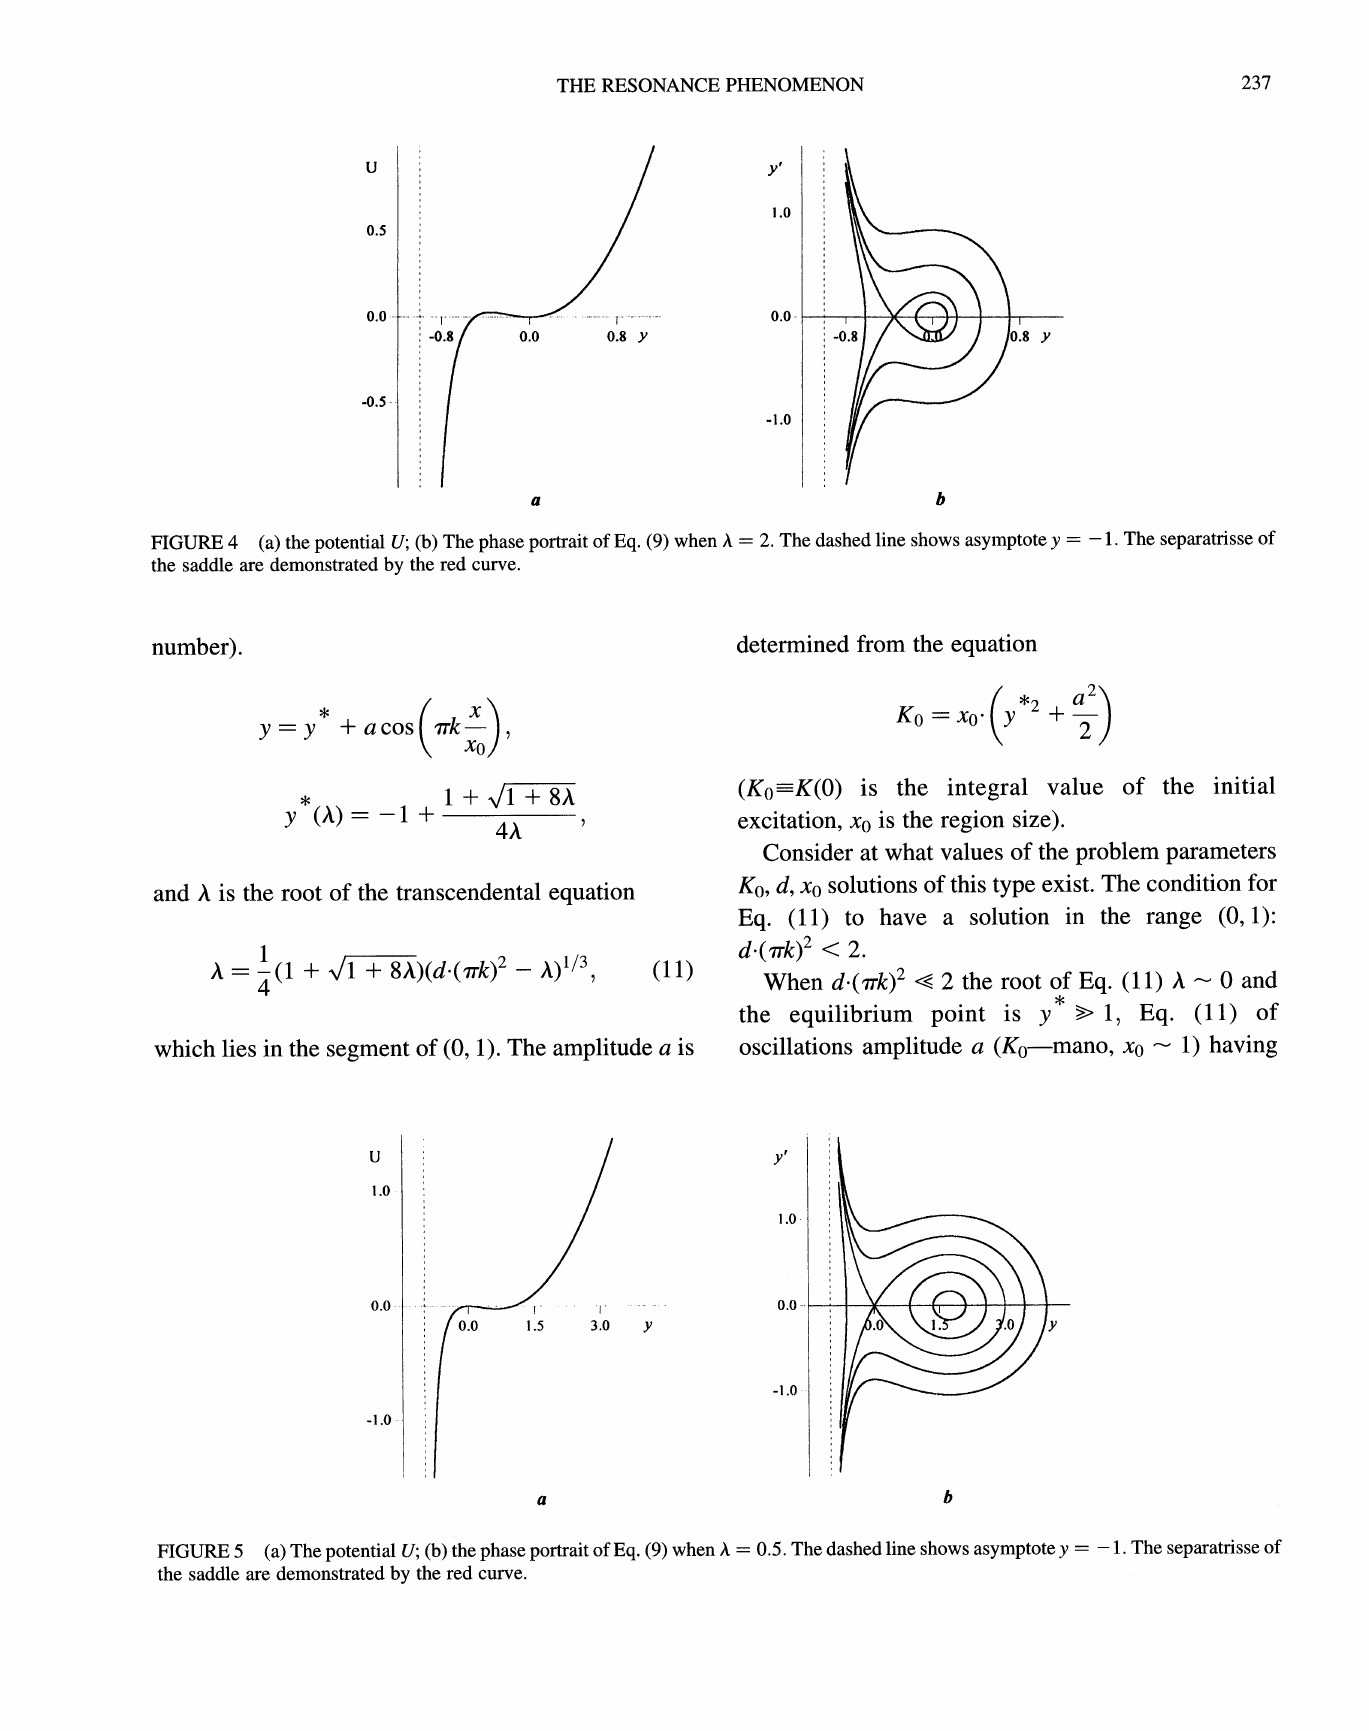
FIGURE 5 (a) The potential U; (b) the phase portrait of Eq. (9) when A 0.5. The dashed line shows asymptote y 1. The separatrisse of the saddle are demonstrated by the red